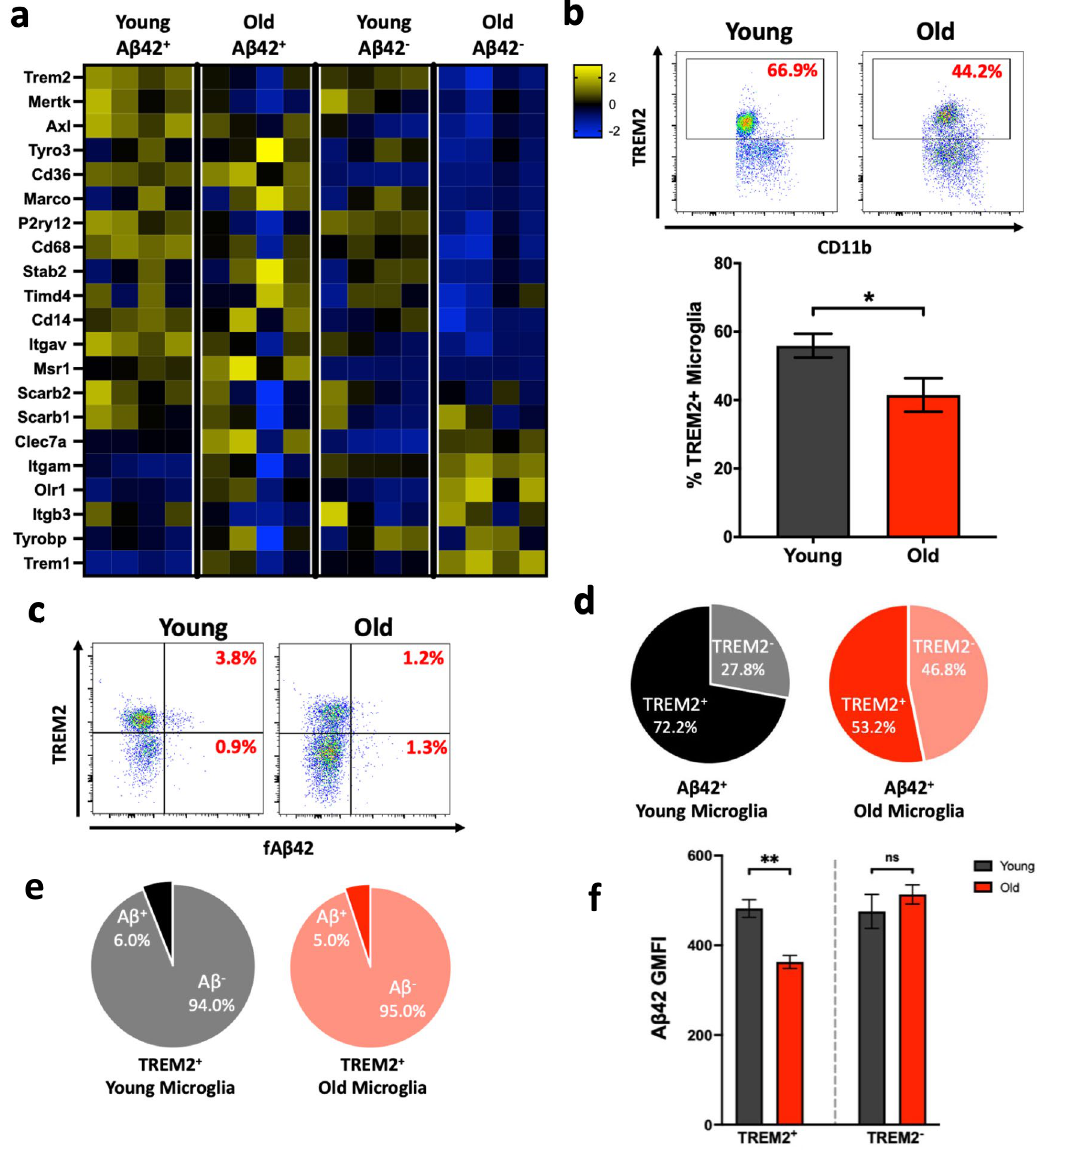
Figure 4. Expression of TREM2, an Aβ42 receptor, is decreased in aging microglia. ( a ) Heatmap representation of phagocytic receptor gene expression levels for Young Aβ42 + , Young Aβ42 − , Old Aβ42 + , and Old Aβ42 − . The scale represents the row Z-score from 2 (highest expression) to − 2 (lowest expression). Young (2 months) and aged (21 months) microglia were incubated with 0.5 μM Aβ42 for 1 h and stained for microglial markers and TREM2 (n = 3/group; replicated 4 times with both male and female mice) ( b ) Representative flow plots (n = 3/ group) of young and aged microglia TREM2 expression and graph of % of young and old microglia that are TREM2 + . ( c ) Representative flow plots of young and aged microglia TREM2 expression and Aβ42 uptake. ( d ) Graphs showing the average percentage of TREM2 expression in young (black) and old (red) Aβ42 + microglia and ( e ) Average percentage of Aβ fluorescence in young (black) and old (red) TREM2 + microglia. ( f ) Geometric mean fluorescence of Aβ42 in TREM2 + and TREM2 − Aβ42 + microglia. * p ≤ 0.05, ** p ≤ 0.01, mean ± s.e.m, Student’s t